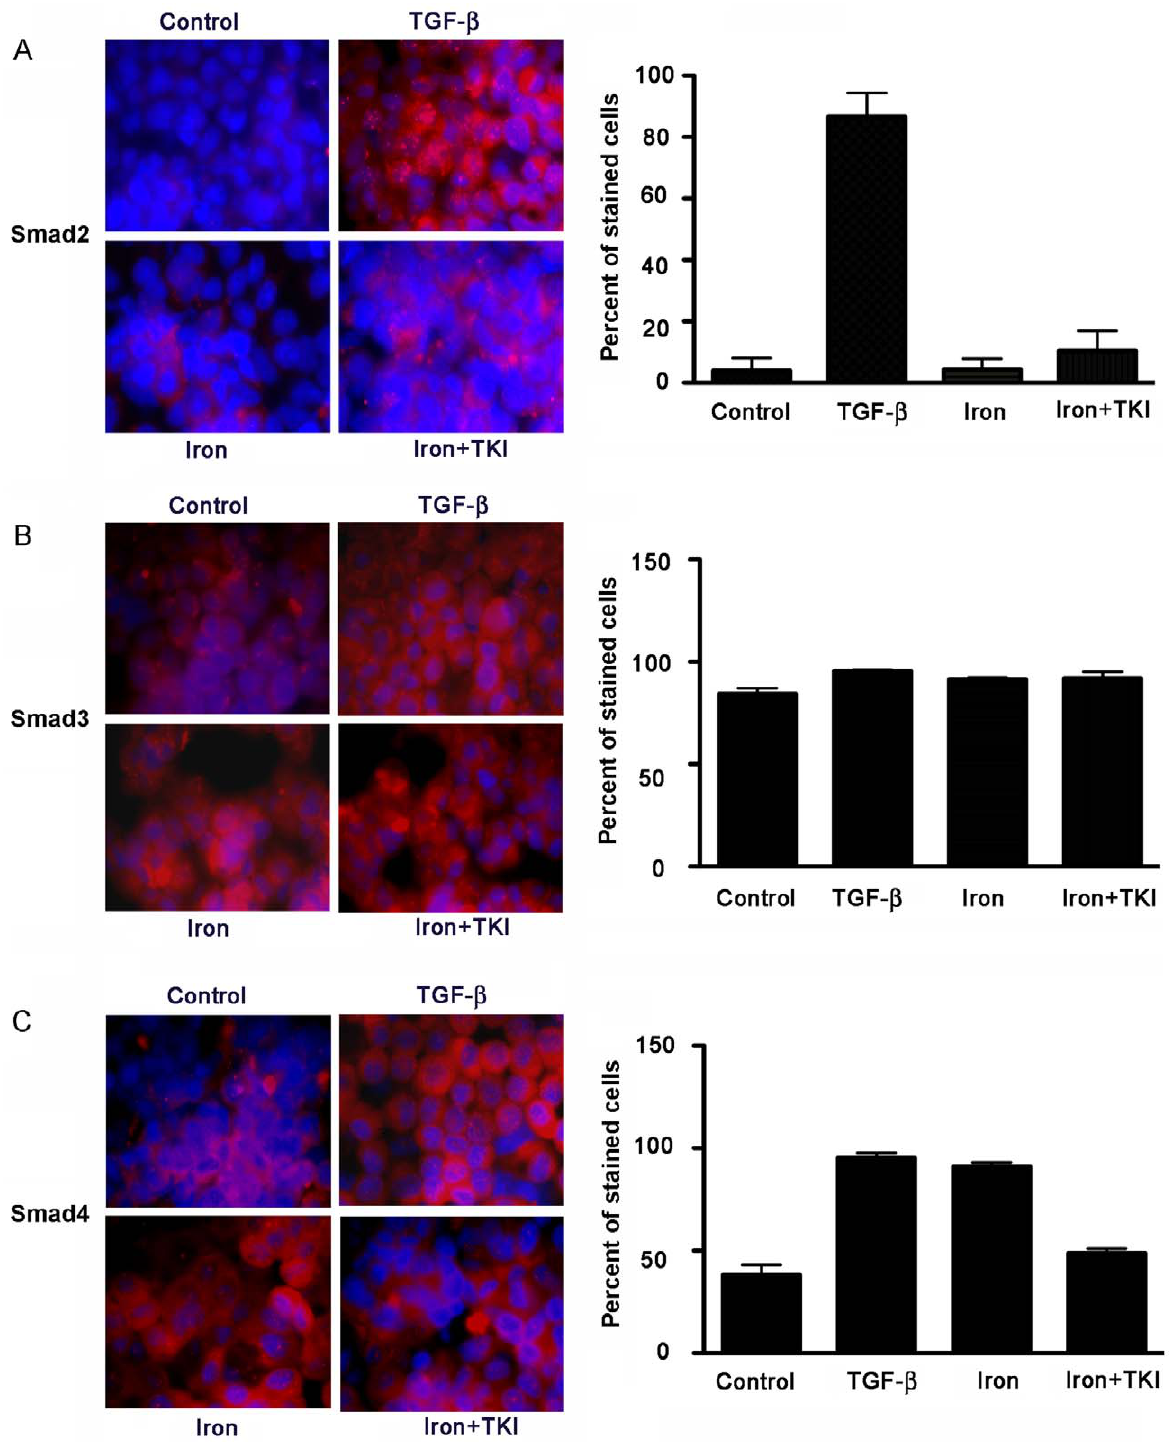
Figure 3. Regulation of SMAD expression in cells. Cells were cultured with 20 ng/ml TGF- b , 100 m M iron, or 100 m M iron plus 480 ng/ml TKI for 48 h. Immunostaining of cultured cells is shown in representative images for phosphorylated SMAD-2 (A), SMAD-3 (B) and SMAD-4 (C) (red color with DAPI counterstaining of nuclei in blue color). Morphometric analysis of larger samples of cells is given in accompanying charts. TGF- b increased expression of SMAD-2 and SMAD-4 but not SMAD-3. By contrast, iron had no effect on expression of SMAD-2 or SMAD-3. However, iron increased SMAD-4 expression, which was partly blocked by TKI. These results indicated differences in the nature of intracellular signaling in cells treated with iron or TGF- b although activation of SMAD-4 by both iron and TGF- b indicated confluence of TGF- b /BMP signaling in these conditions. This was emphasized by lowering of SMAD-4 expression in cells treated with iron plus TKI. Orig. mag., x630.